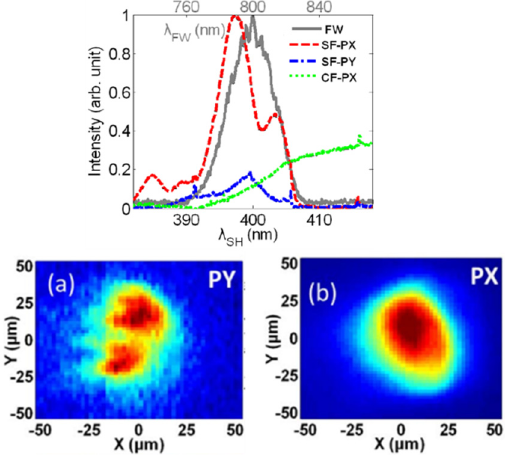
Figure 11. Upper panel: The second harmonic spectrum obtained in SSTF with the fundamental laser polarization along the y axis (SF–PY), x axis (SF–PX) and conventional focusing with the fundamental laser polarization along the x axis (CF–PX) schemes. Lower panel: Spatial patterns of second harmonic generated by the SSTF scheme with the fundamental laser linearly polarized along ( a ) y axis; and ( b ) x axis. The incident pulse energy is ~1 mJ and the focal length of the focusing lens is 75 cm. Reproduced with permission from [25], Copyright The Optical Society, 2014.